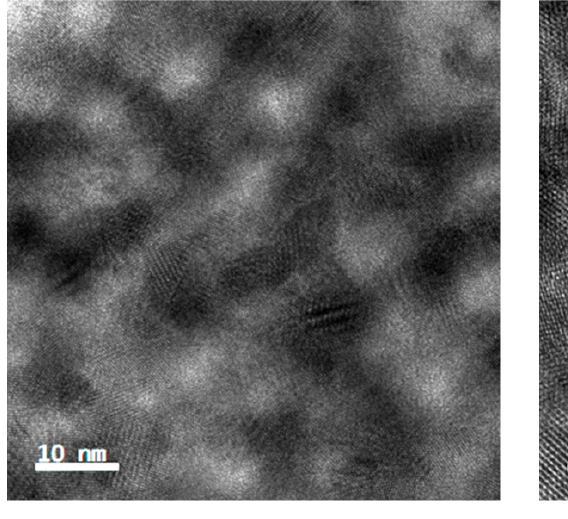
Figure 3. SEM images of the PbS QD films capped with ( a ) EDT, ( b ) TBAI, ( c ) CTAB, and ( d ) Na 2 S. (scale: 100 nm).